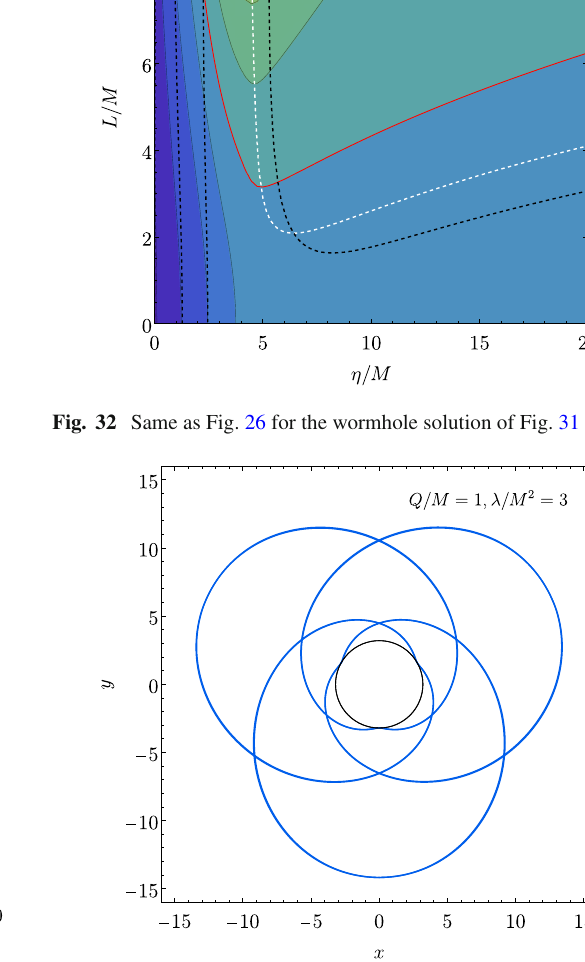
Fig. 33 Projection of a closed orbit for L = 3 , E = 0 . 95 with 3-fold symmetry, passing the throat 6 times during 8 revolutions